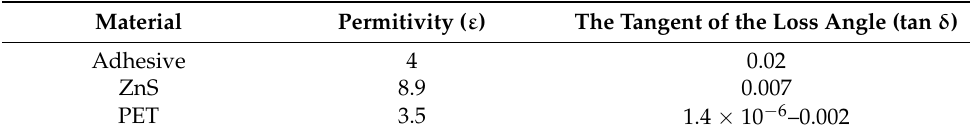
Table 1. Electrical characteristics of the materials for the holographic label. Material Permitivity ( ε ) The Tangent of the Loss Angle (tan δ )